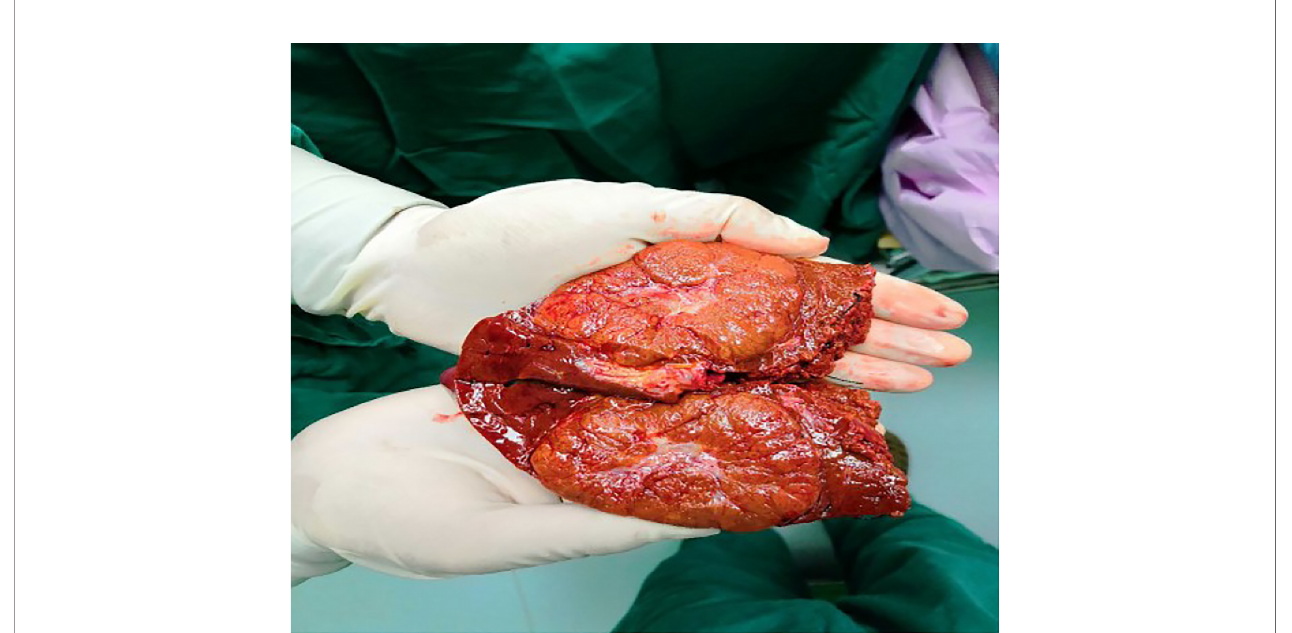
FIGURE 2 | The tumor is nodular to the naked eye, and the cut surface is grayish yellow, and blood is